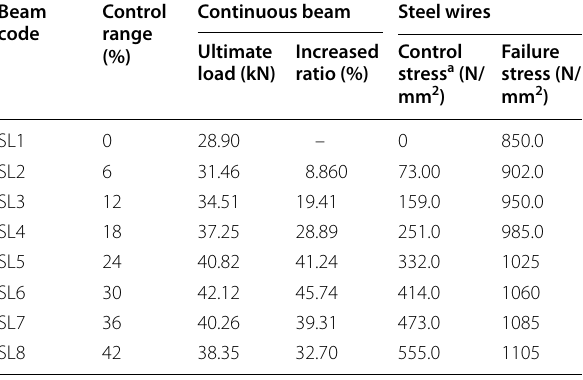
Table 7 FEA results